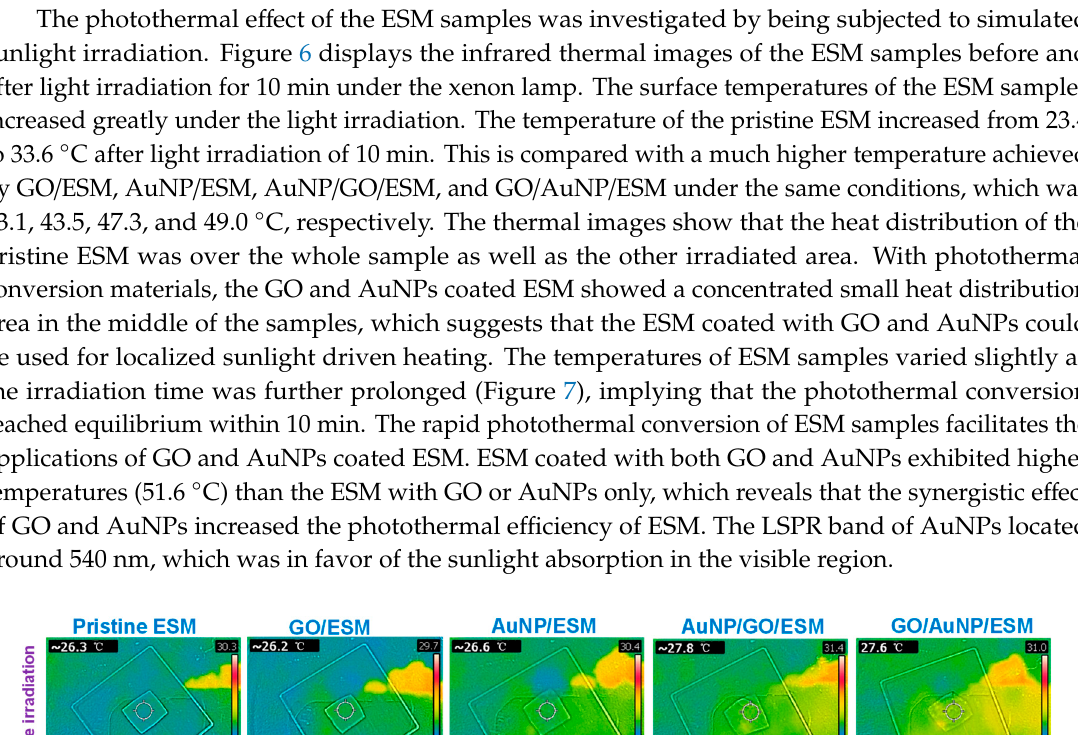
Figure 5. ( a ) Raman scattering spectrum of GO/ESM. ( b ) TGA curves of different ESM samples.